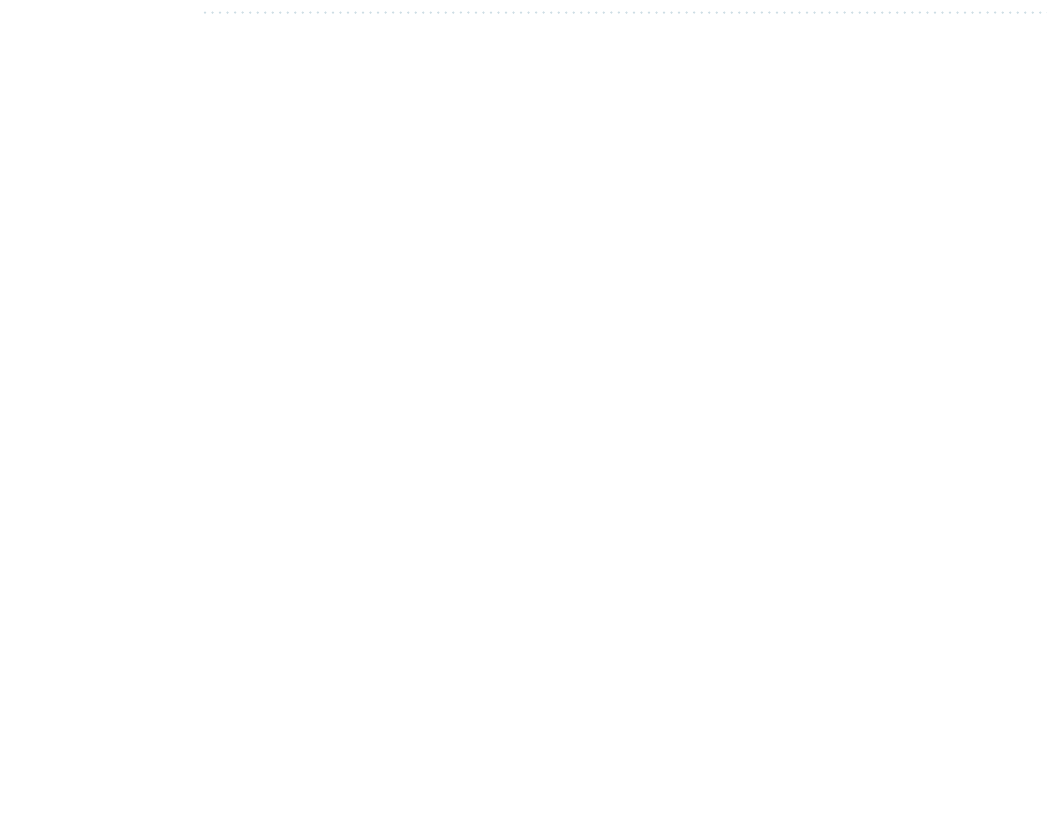
Figure 16. Relationship between the maximum transmission value of the low PBG edge and different values of ( a ) a 1 , ( b ) W 2 , ( c ) N, and ( d ) d. Relationship between the FOM value of the proposed biosensor II and different values of ( e ) a 1 , ( f ) W 2 , ( g ) N, and ( h )